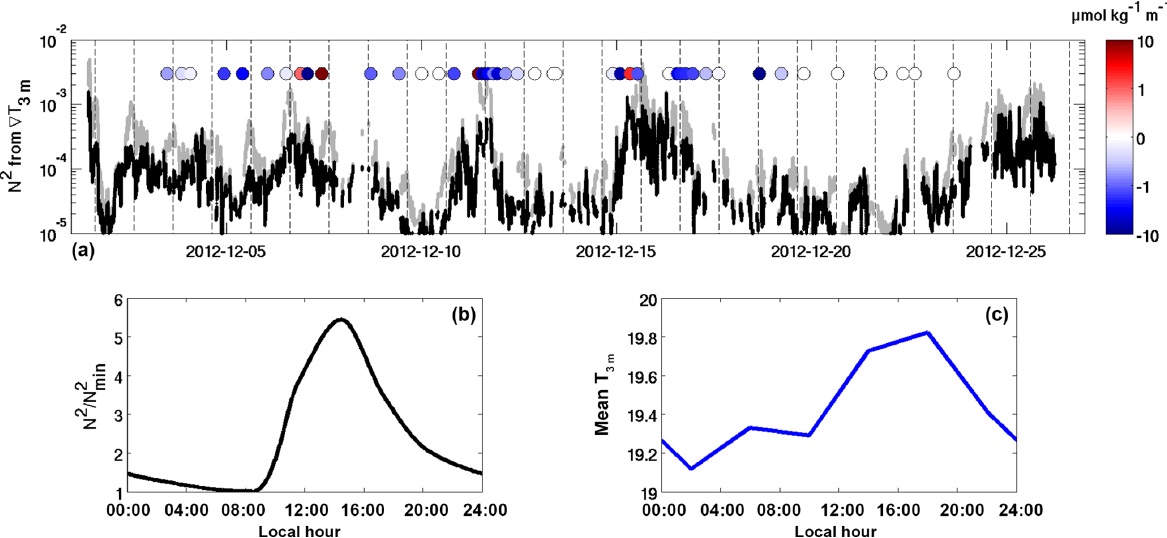
Figure 6. (a) Observed near-surface N 2 O gradients vs. stratification at 3m, in December 2012. Grey line: N 2 at 3m estimated from hull temperature variance and ship motion variance; data gaps are during ship stations. Diurnal periodicity is visible most days. Black line: same with mean diurnal cycle subtracted, by that mimicking the expected minimum nighttime stratification at each location. Colored dots: N 2 O gradient between about 10 and 5m depth from ship-based discrete sampling. Dashed lines mark 15:00h local time. (b) Mean diurnal cycle of stratification at 3m, relative to minimum nighttime stratification N 2 . (c) Mean diurnal cycle of temperature at 3m. min